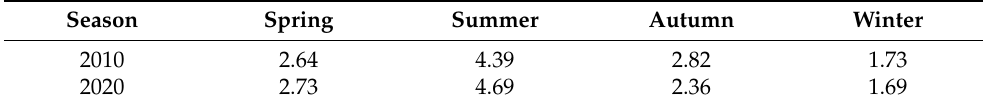
Table 3. Standard deviation of LST in all seasons ( ◦